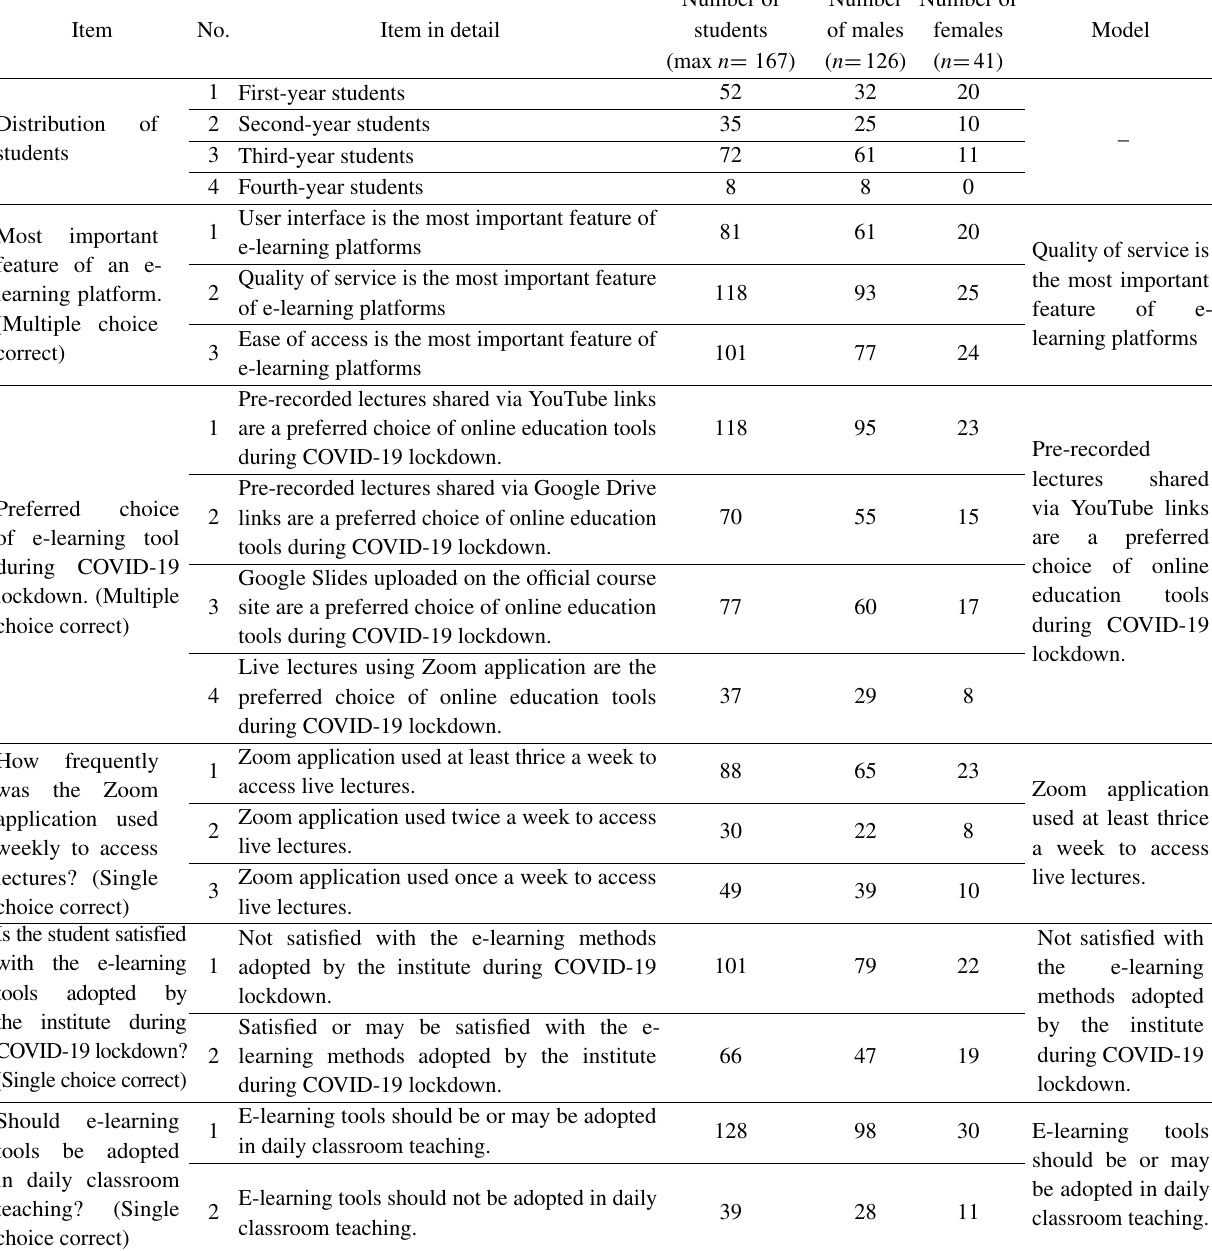
Table 1 Students’ response to survey conducted regarding e-learning practices adopted by teaching faculty of Thapar Institute of Engineering and